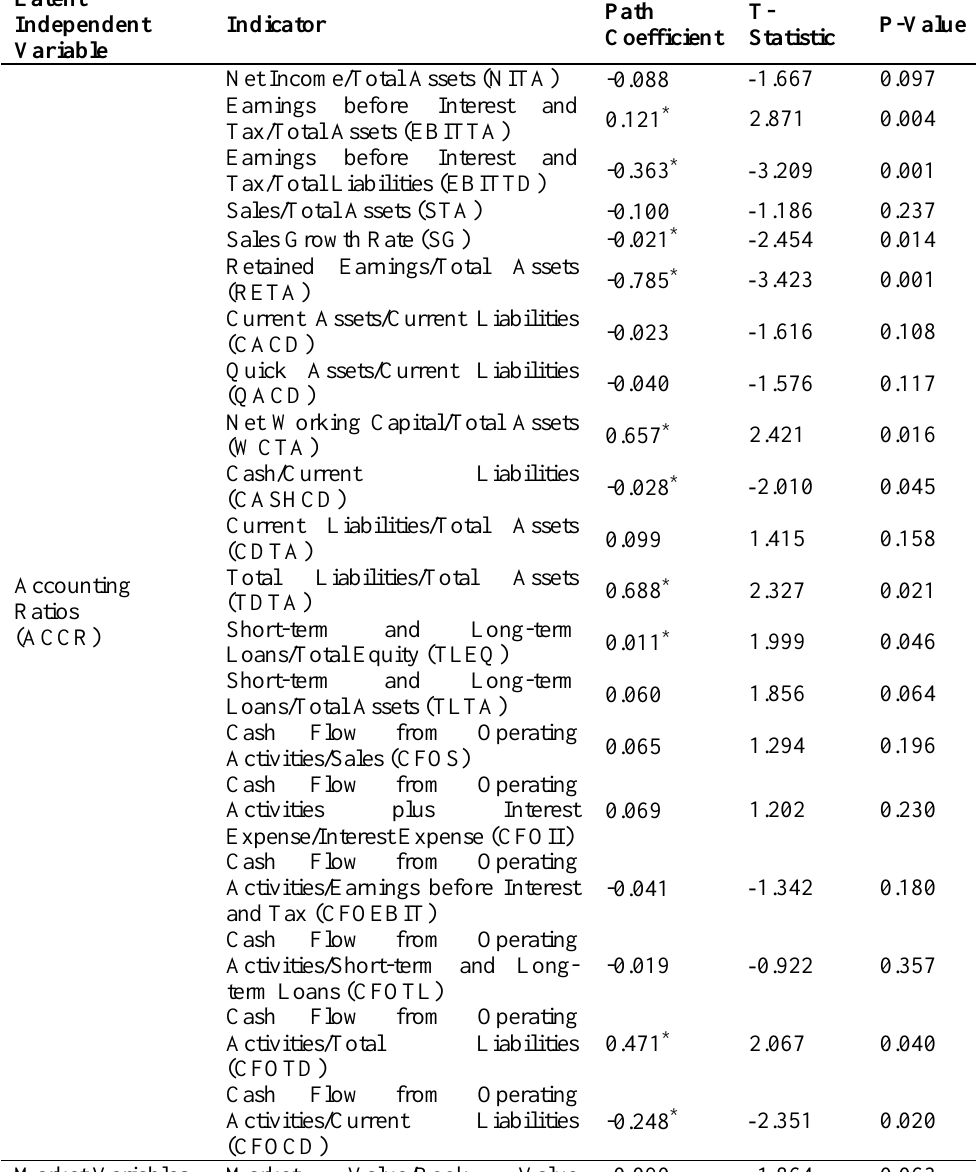
Table (11). Path Coefficient, T-Statistic and P-Value for Indicators